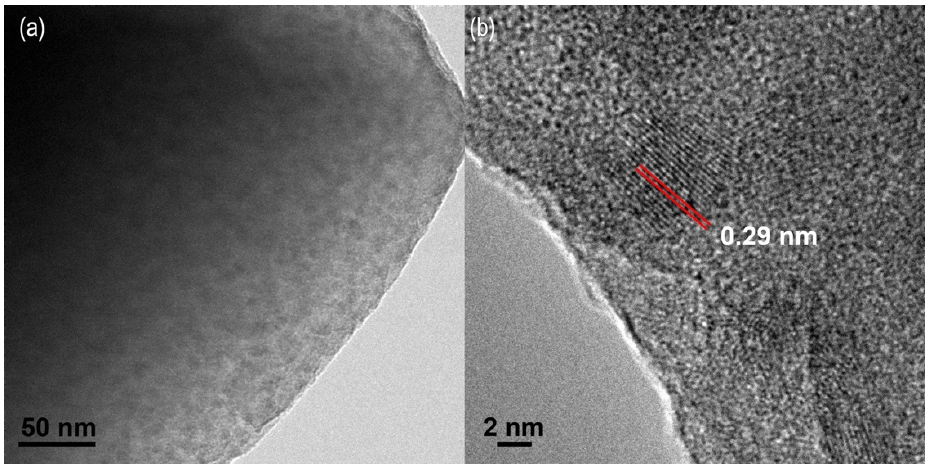
Figure 6. ( a ) TEM and ( b ) HRTEM images of the Au-doped glass sample heat treated at 770 °C for 20 h.